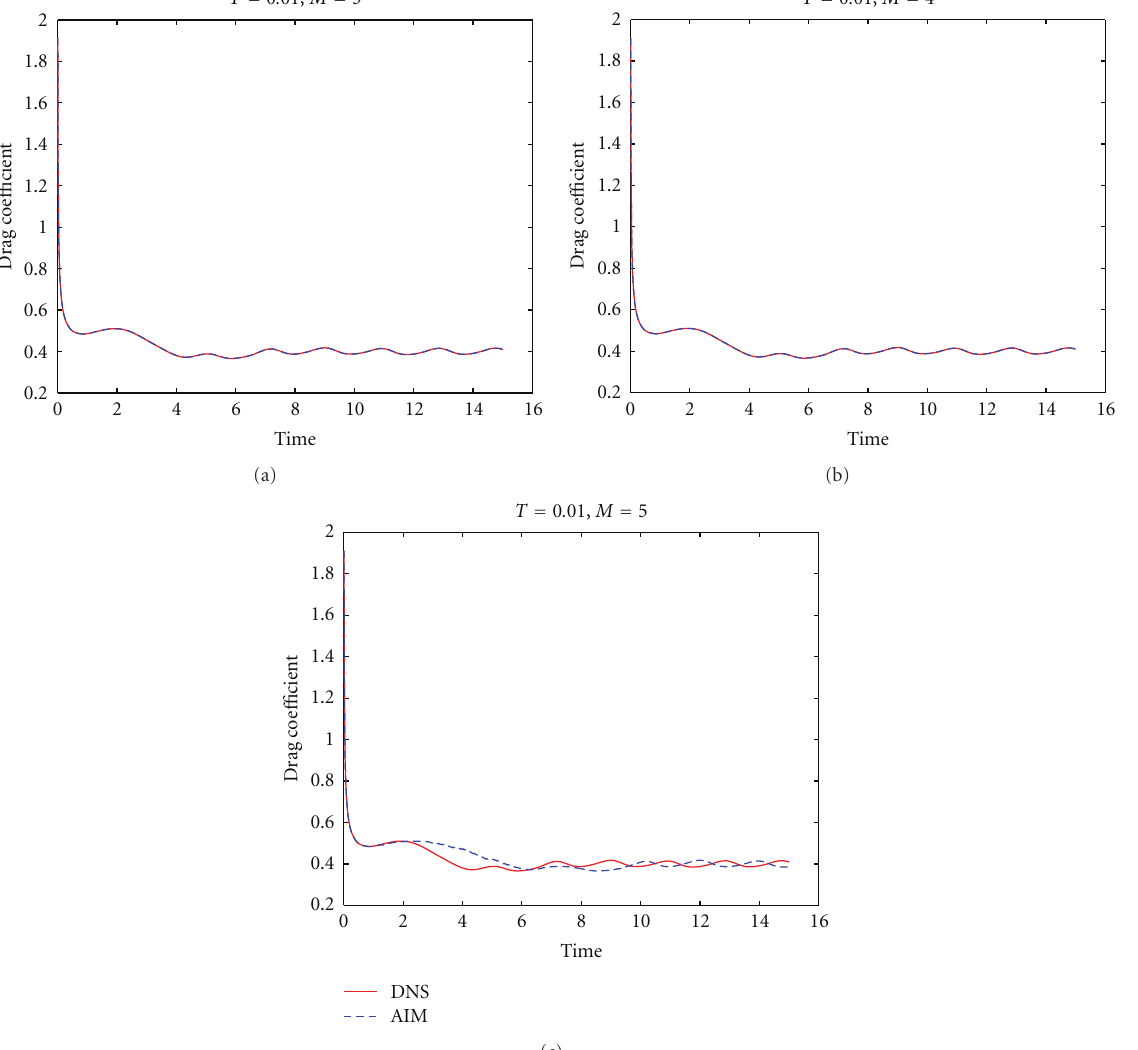
problems [13], one can assume that the flow field u ( t , x )